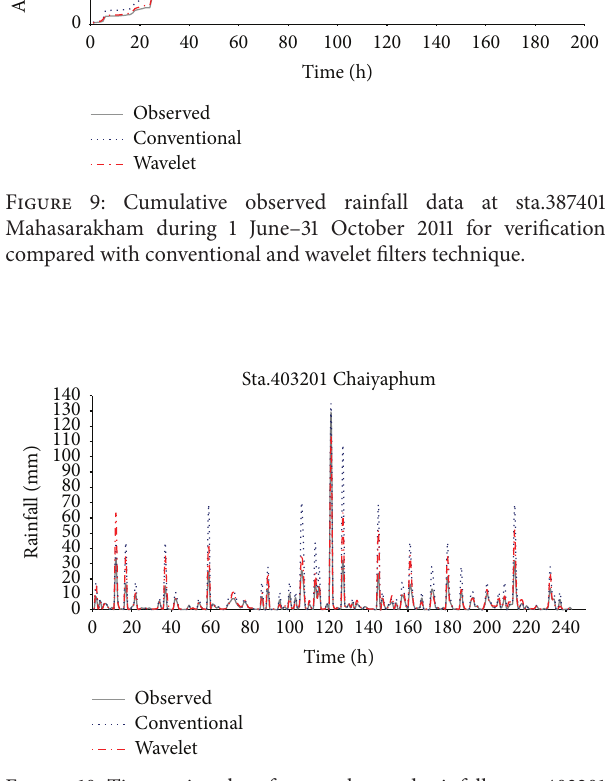
Figure 13: Cumulative observed rainfall data at sta.405201 Roiet during 1 June–31 October 2011 for verification compared with conventional and wavelet filters